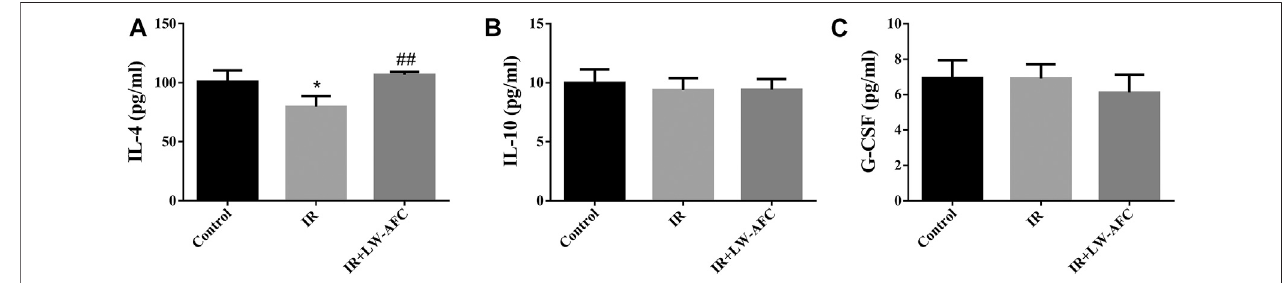
FIGURE 8 | LW-AFC increases the level of anti-in fl ammatory factor in the hippocampus of IR mice on day 1 after irradiation. Concentrations of (A) IL-4, (B) IL-10, and (C) G-CSF were detected. The values denote mean ± S.D., n (cid:2) 4. * p < 0.05, versus the control group; ## p < 0.01, versus the IR group. Abbreviation: IR,